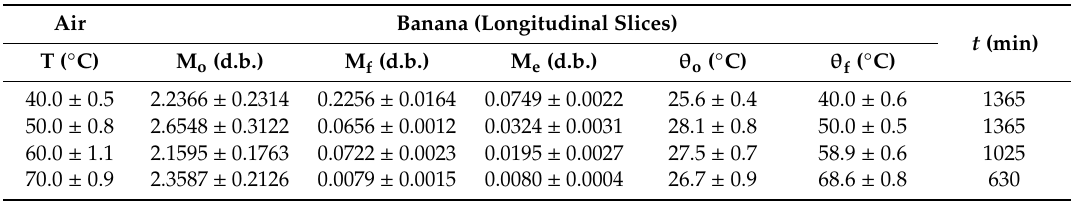
Table 2. Experimental hydric and thermal parameters of the banana (longitudinal slices) used in this